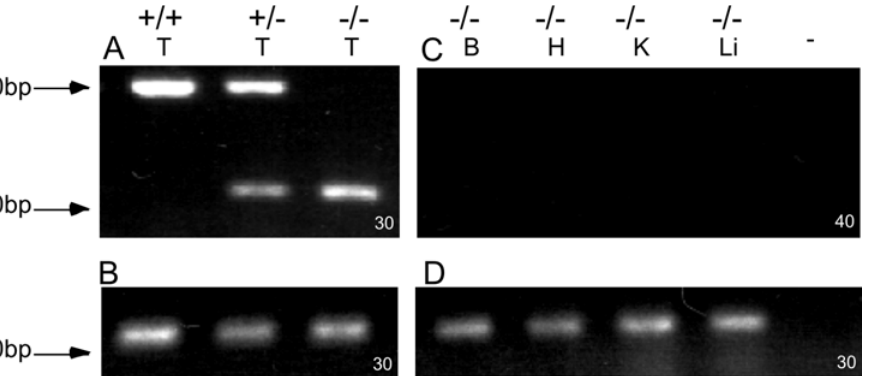
Figure 6. PCR from Exons 1 through 5 from WT and knockout mouse tissues. (A) and (C) PCR across exons 1-5. (A) Testis first strand from WT ( + / + ), Sacy tm1Lex / + heterozygote ( + / 2 ), and Sacy tm1Lex /Sacy tm1Lex homozygous knockout ( 2 / 2 ) mice. (C) First strand cDNA from brain (B), heart (H), kidney (K), or liver (Li) from Sacy tm1Lex /Sacy tm1Lex homozygous knockout ( 2 / 2 ) mice; ( 2 ) indicates no template control. (B) and (D) b -actin controls. The number in the lower right corner of each panel is the number of cycles used in each experiment.